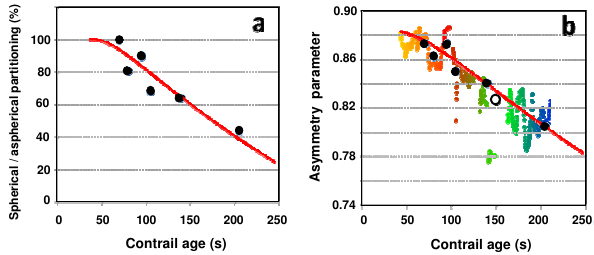
Fig. 5. (a) Spherical/aspherical partitioning ratio (SAR) and (b) asymmetry parameter g versus contrail age. The colored symbols are the measured g -values as in Fig. 3g. The black dots represent the mean retrieval results (see Sect. 5), and the red lines approximate fits. The single open circle shows the result of Febvre et al.